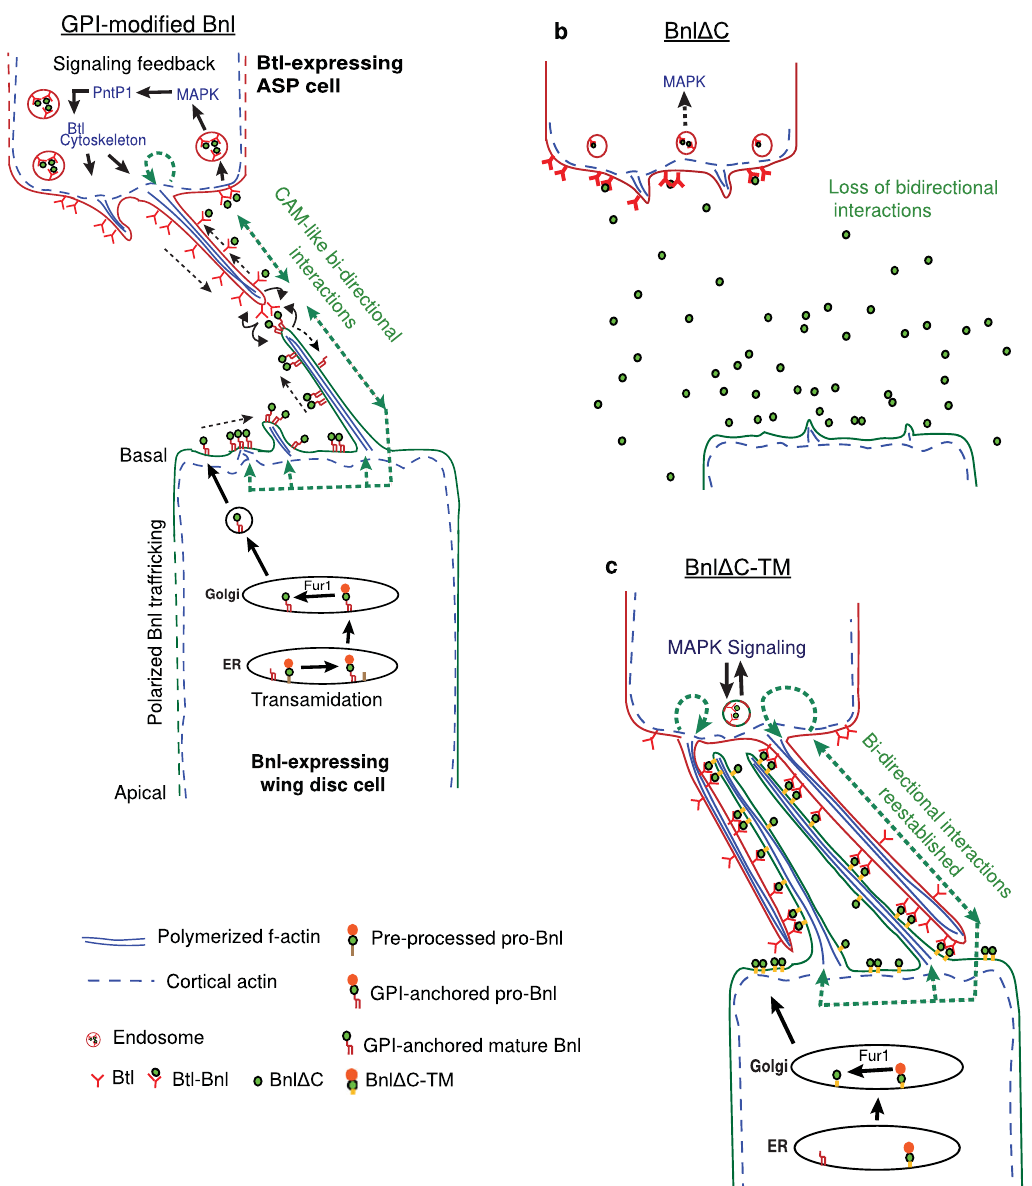
Fig. 10 Dual roles of GPI-anchored Bnl. a A model showing that the GPI-anchored Bnl directs both target-speci fi c cytoneme contact formation and contact-dependent Bnl release. Green dashed arrows, a putative CAM-like local signaling mechanism that can promote polarized cytoskeletal reorganization for cytoneme formation. Black arrow (Bnl source), Bnl processing and traf fi cking 36,67 ; black arrow (ASP cells), a MAPK signaling feedback that promotes the formation of Bnl-receiving ASP cytonemes toward the source 9 . b , c Schematic models illustrating why freely secreted Bnl Δ C might